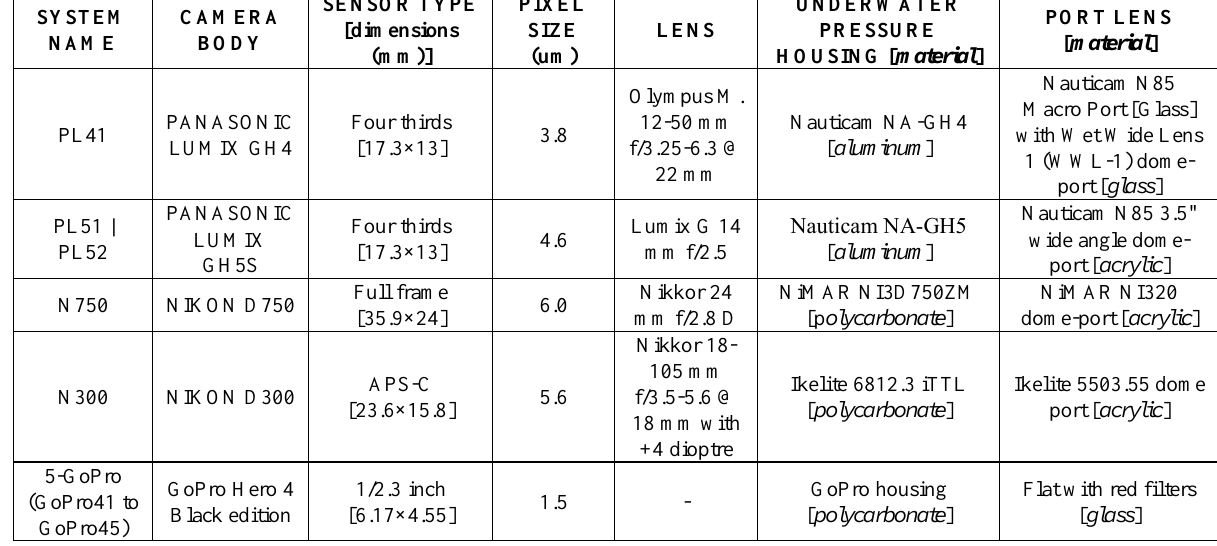
Table 1: Key parameters of the used underwater camera systems.